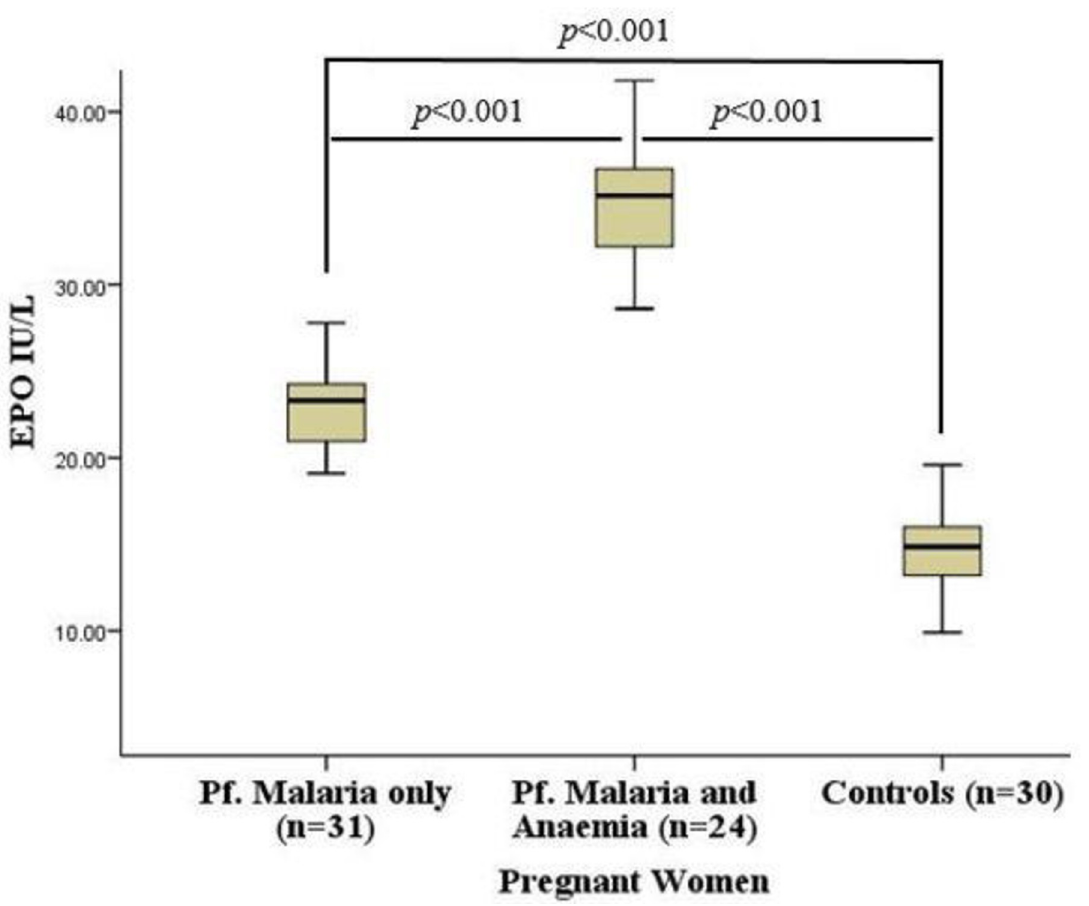
Fig 1. Serum erythropoietin levels among pregnant women stratified by the presence or absence of P . falciparum malaria. EPO = Erythropoietin, p/ μ L = Parasite per Microlitre. Data were compared using Mann Whitney U-Test. p < 0.05 was considered